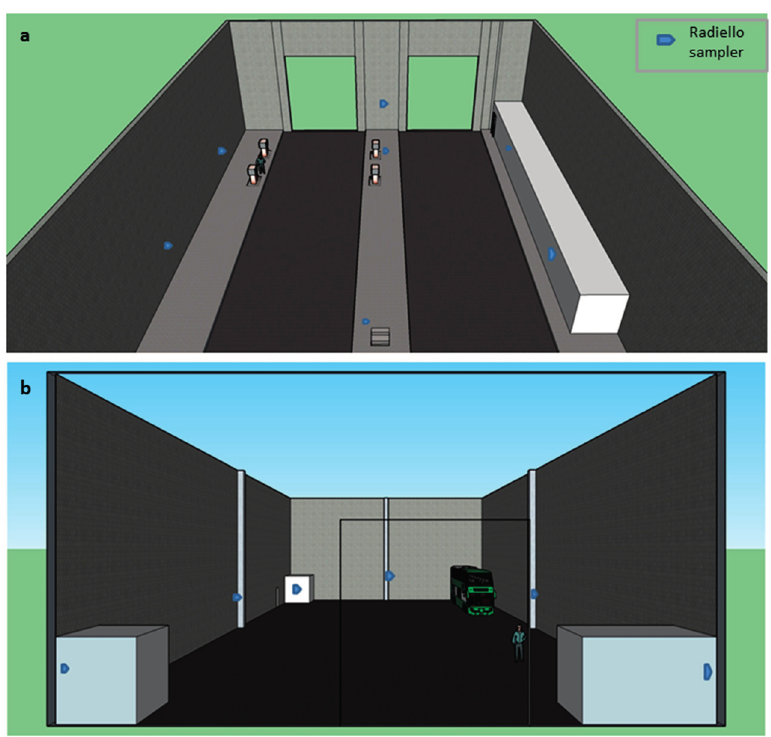
Figure 1. Radiello passive sampler positions in the ( a ) fuel bay and ( b ) workshop. Passive samplers were positioned equidistant as possible, at 2 m heights. (Overhead roofs and front walls have been made transparent for viewing purposes. Offices are displayed as white boxes). The fuel bay is adjacent to the workshop at the bus depot.